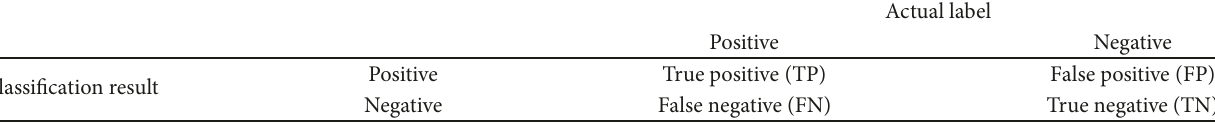
Table 2: The confusion